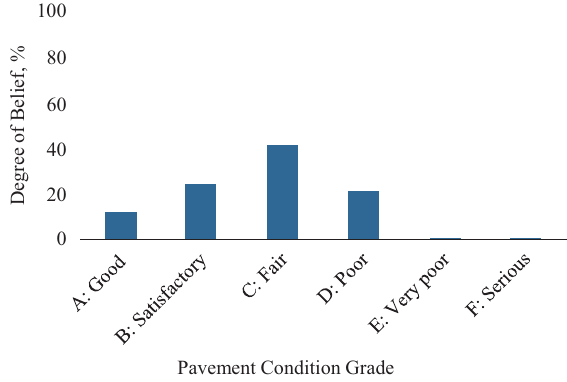
Figure 2. Overall condition assessment of pavement Section 1